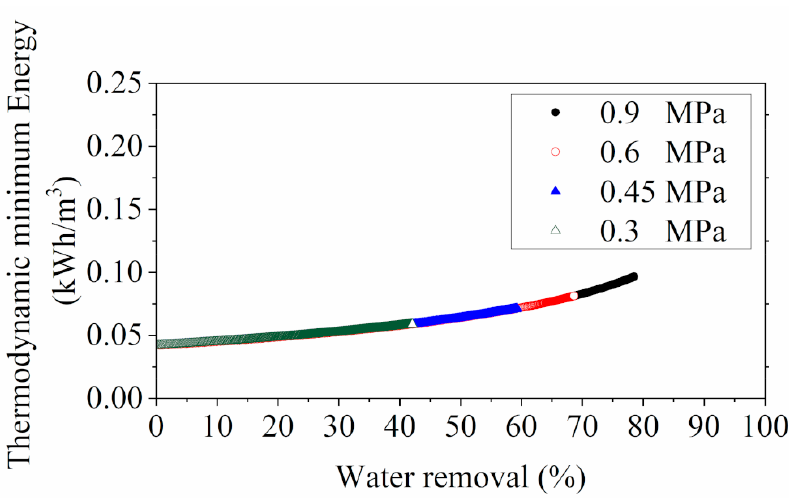
Figure 6. Thermodynamic minimum energy for RO concentration processes with different operating feed